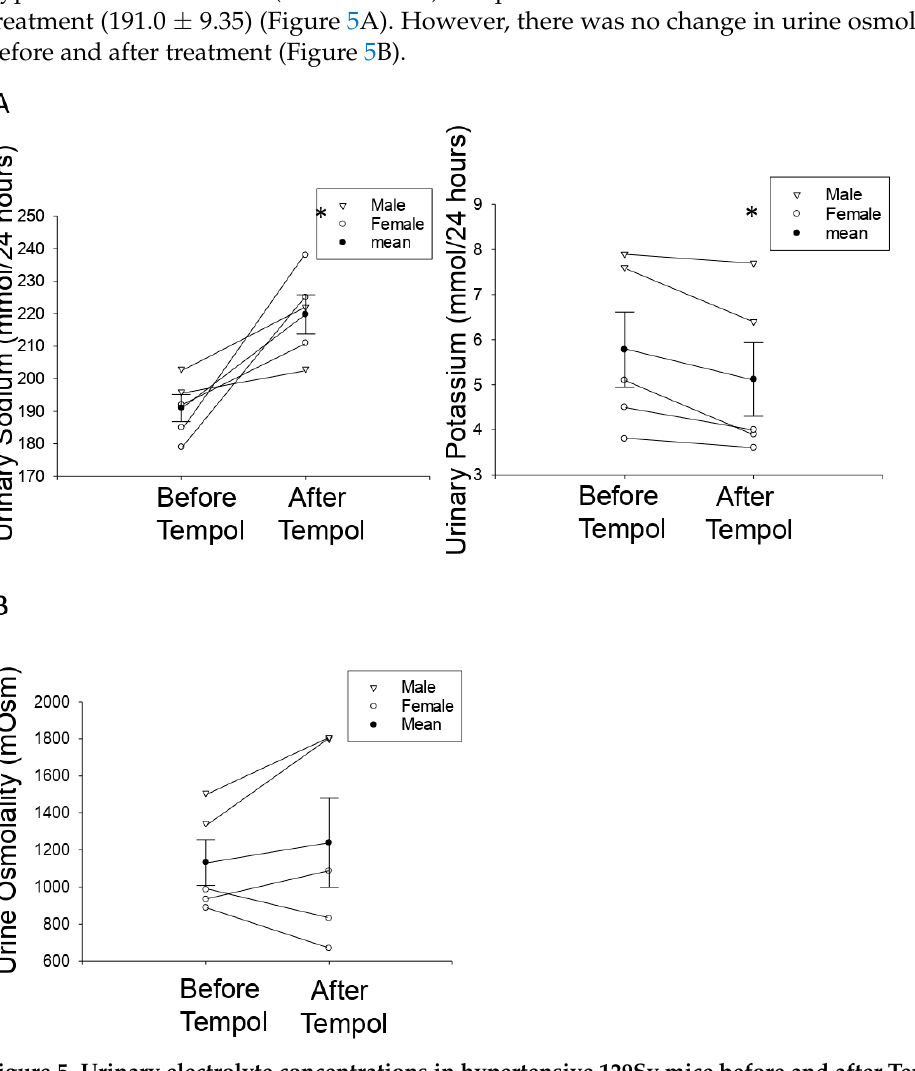
Figure 5. Urinary electrolyte concentrations in hypertensive 129Sv mice before and after Tempol infusion: ( A ) Urinary sodium concentration ( left ) and urinary potassium concentration ( right ) for salt-induced hypertensive 129Sv mice before and after Tempol infusion. ( B ) Urine osmolality for salt-induced hypertensive 129Sv mice before and after Tempol infusion. N = 5 mice per group. A paired t-test was performed and a * represents a p -value <0.05.